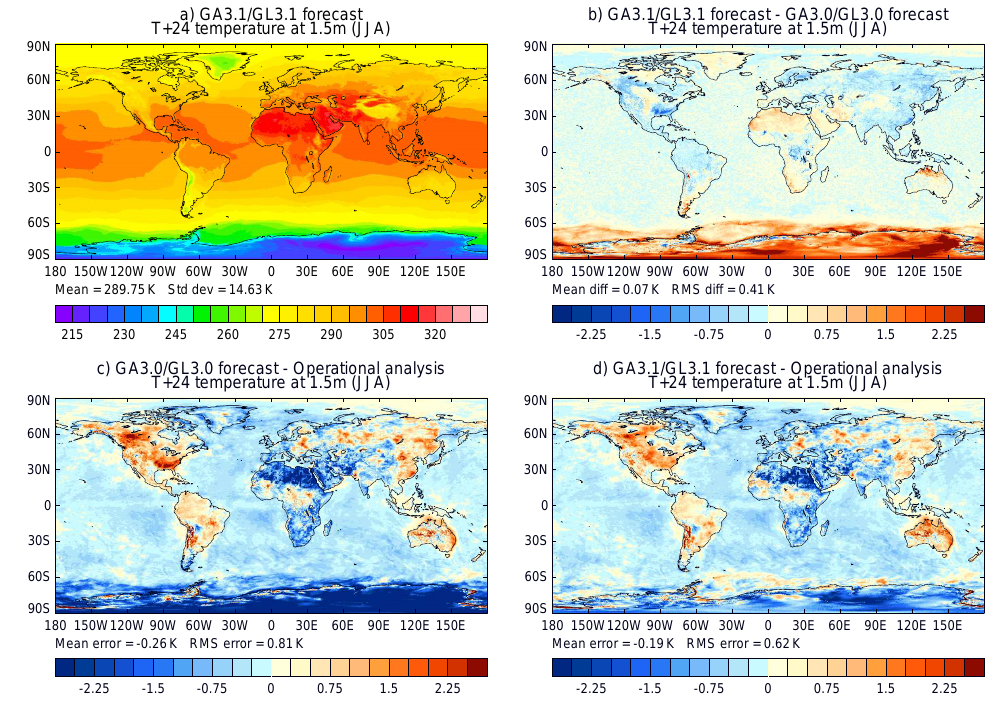
Fig. 8. Mean 24 hour forecast 1.5 m temperatures during 10 N320 NWP case studies in JJA. (a) full field from GA3.1/GL3.1, (b) model difference (GA3.1/GL3.1 minus GA3.0/GL3.0), (c) GA3.0/GL3.0 bias (GA3.0/GL3.0 minus Met Office operational analyses) and (d) GA3.1/GL3.1 bias (GA3.1/GL3.1 minus analyses). and 00:00 UTC (T+12, 18, 36, 42 etc.) have a warm bias of about 0.5 ◦ C in GA3.1/GL3.1. This is exacerbated in GA3.0/GL3.0, which as with 12:00 UTC is between 0.2 and 0.5 ◦ C warmer than GA3.1/GL3.1. Figure 9b shows verifi- cation of the T+24 temperature profile against radiosondes released from Northern Hemisphere land stations. As ex- pected, the main difference is constrained to the lower tro- GA3.0/GL3.0 and GA3.1/GL3.1 configurations described in Sect. 5 are in the land surface model and the boundary layer scheme. As in Fig. 9a, we see that GA3.0/GL3.0 is warmer sistent with the screen-level